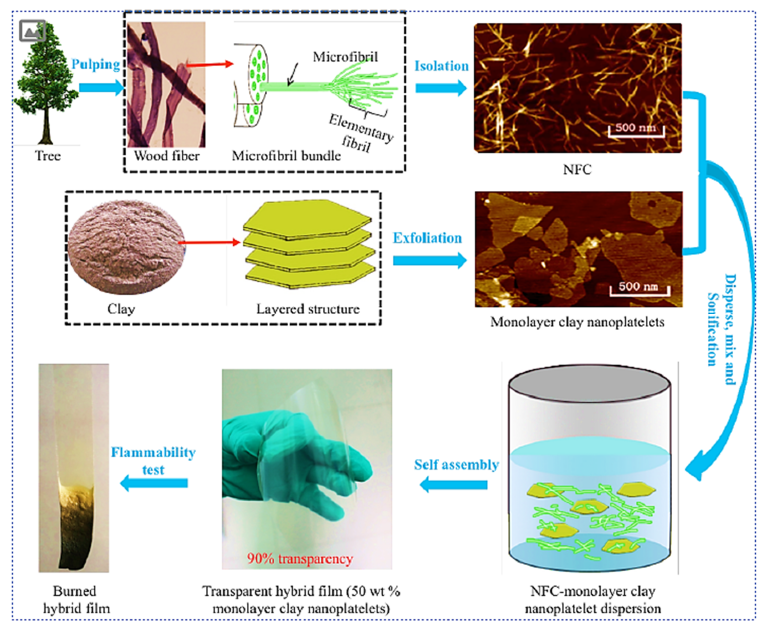
Figure 4. Schematic of transparent nanofibrillated cellulose (NFC) monolayer/nanoclay nanoplate- let-based hybrid films with self-extinguishing behavior (90% transparency at 600 nm). One-dimen- sional nanofibrillated cellulose was extracted from wood pulp through mechanical and chemical treatments and mixed with uniformly dispersed nanoclay nanoplatelets in water. The nanofibril- lated cellulose dispersed monolayer clay nanoplatelets suspension was blended with 0.5 wt.% clay nanoplatelet suspension using mechanical stirring and ultra-sonication methods. Water evapora- tion induced self-assembly was used to prepare a highly transparent NFC-monolayer clay nano- platelet hybrid film with superb self-extinguishing effect [113]. Reproduced with permission from ACS.